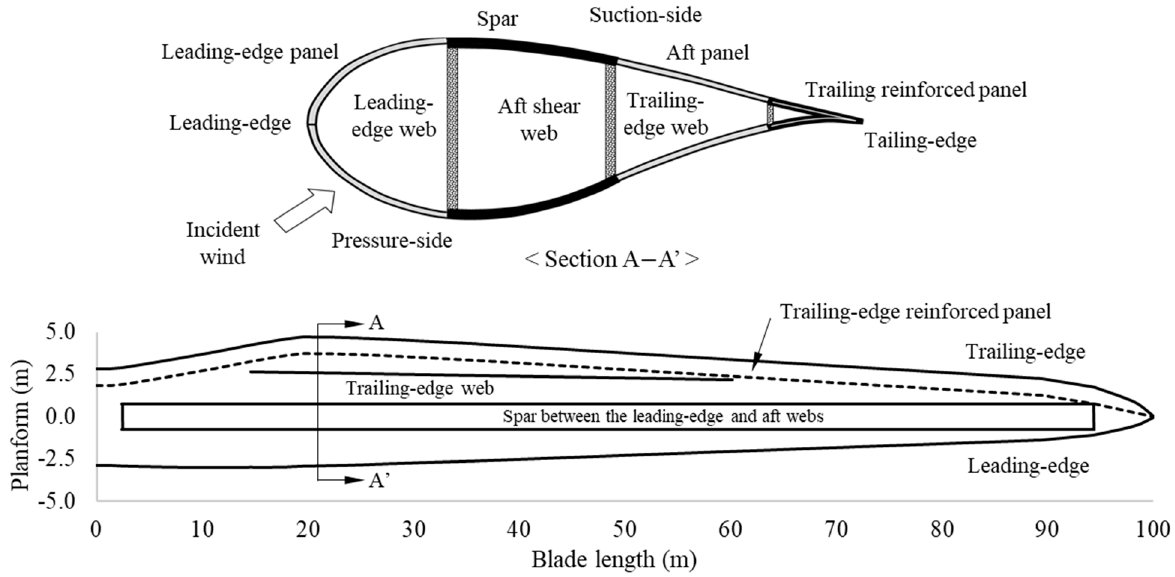
Figure 1. Planform of SNL blade with cross-sectional view A − A’. The blade aerodynamic shape is defined using the span-wise chord, twist and thickness distributions. The maximum chord of 7.63 m occurs at the blade length of 19.5 m, and the maximum twist of 13.3 degrees occurs at the root. The blade thickness is achieved by deploying different airfoils at various span-wise locations along the blade